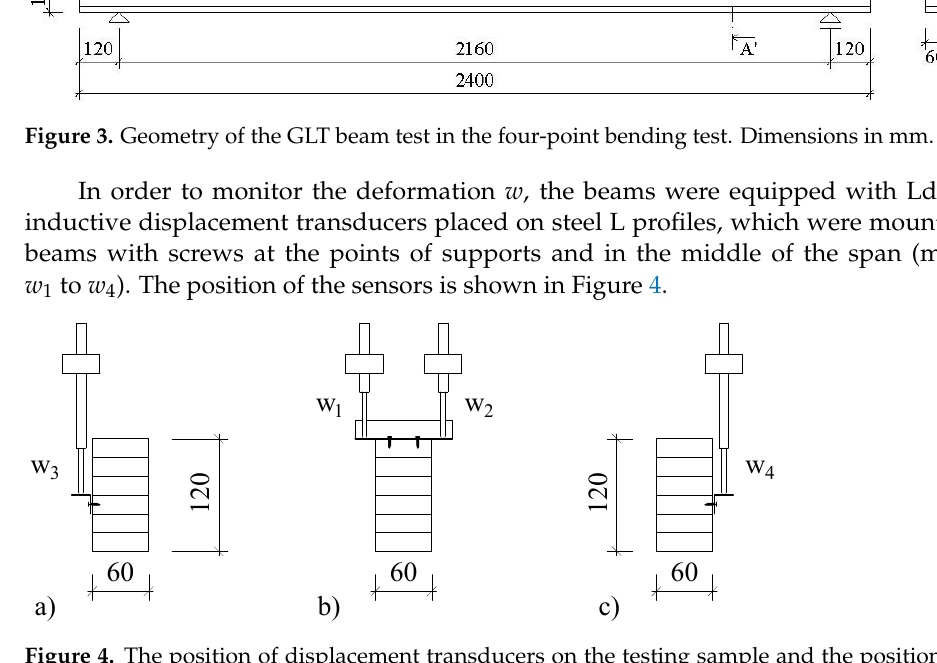
Figure 4. The position of displacement transducers on the testing sample and the position of the cross-sections corresponding to Figure 3: ( a ) at the left support, ( b ) in the middle of the span, and ( c ) at the right support. Dimensions in mm.